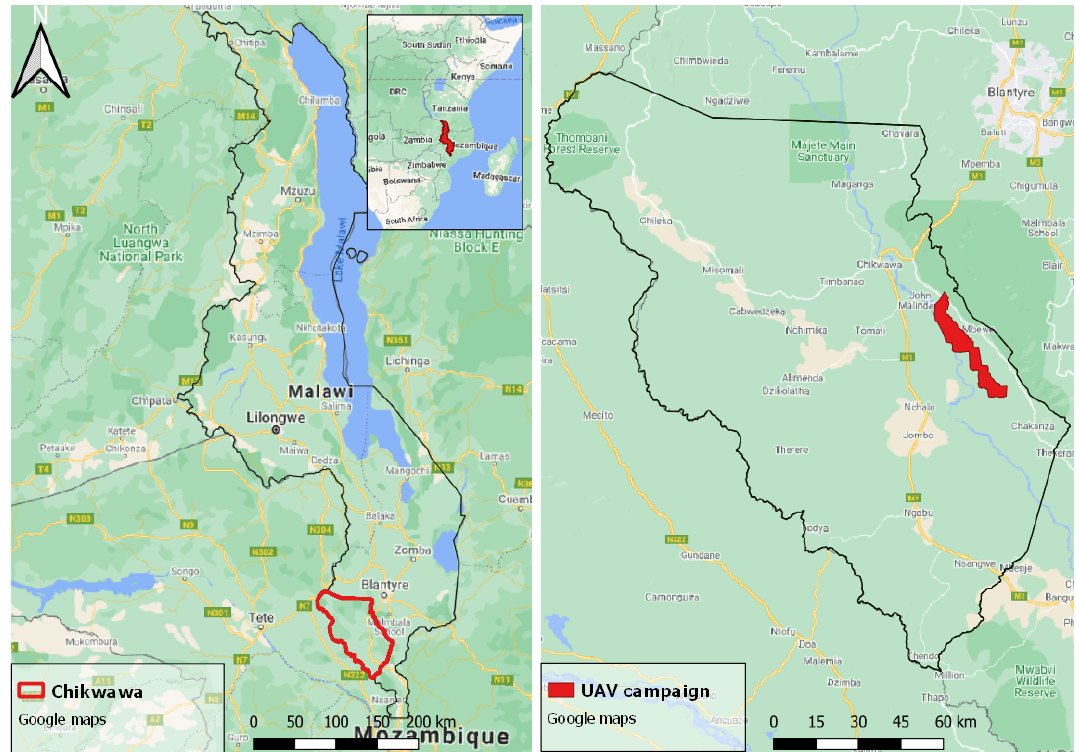
Figure 1. The geographical location of Malawi (left) and the District of Chikwawa (right). © Google Maps,